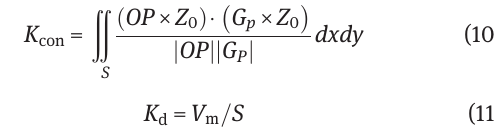
fractions (10, 20, 22, 27, 45, and 70 %) were chosen to show the variation tendency for the HRS (Figure 3) and LMC process (Figure 4). At an initial stage, the heat is